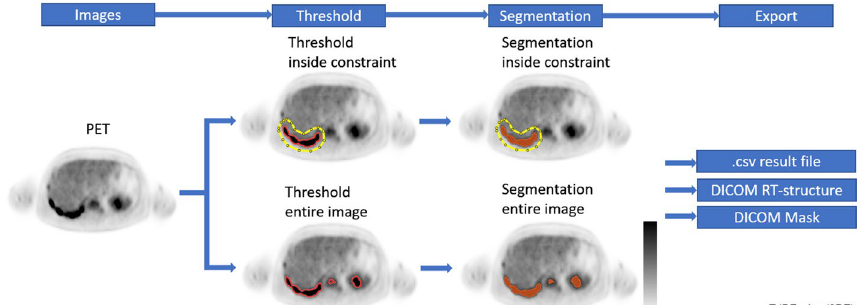
Fig. 13 Workflow for multi-threshold segmentation using the contour tool on a positron emission tomography (PET) image. The orange outline indicates a preview of the contour. The filled region (orange) is the resultant contour from a constraint (yellow) or the entire